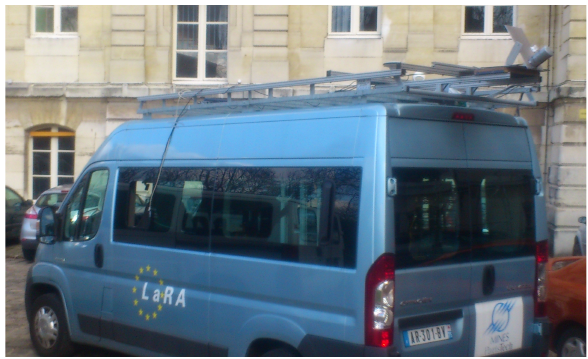
Figure 1: MLS prototype: L3D2